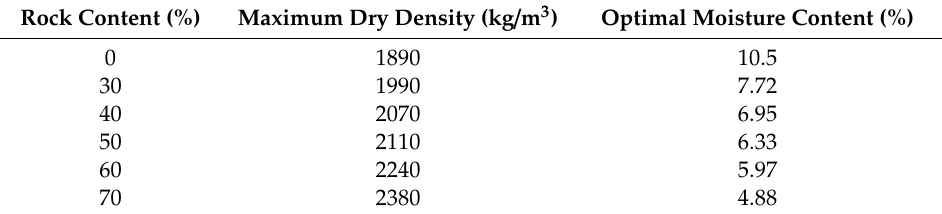
Table 2. Results of soil-rock mixture (SRM) compaction tests at di ff erent rock